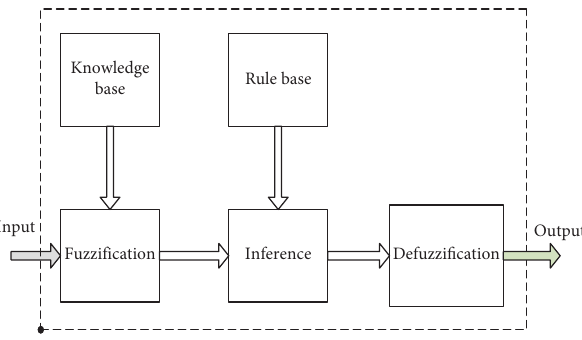
Figure 3: Basic structure of fuzzy logic control